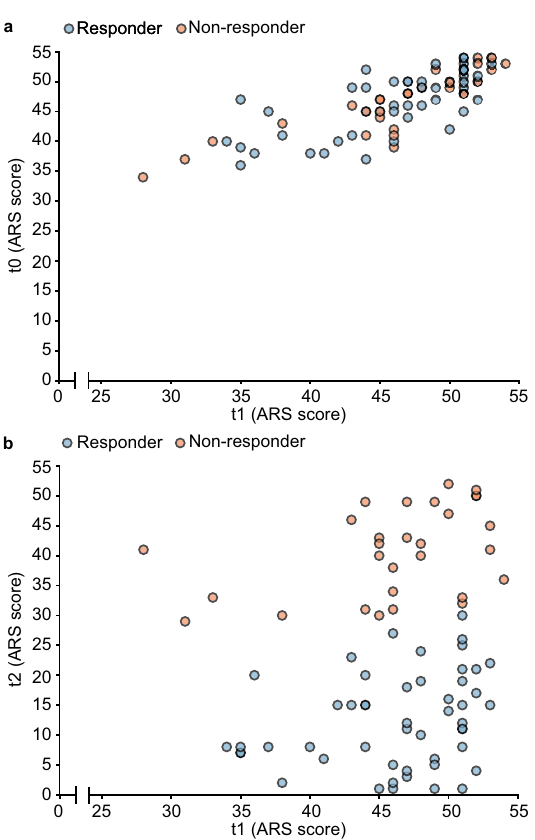
Figure 2. ARS scores of all participants (n = 79) at t0, t1 and t2. Blue dots represent ARS scores of responders (≥ 40% ARS score decrease at t2 compared to t1; n = 50). Red dots represent ARS scores of non-responders (< 40% ARS score decrease at t2 compared to t1; n = 29). ARS scores (minimum score = 0, maximum score = 54) at: ( a ) t0 versus t1. ( b ) t1 versus t2. See Supplementary Fig. S2 for t0 versus t1 ARS scores for all participants